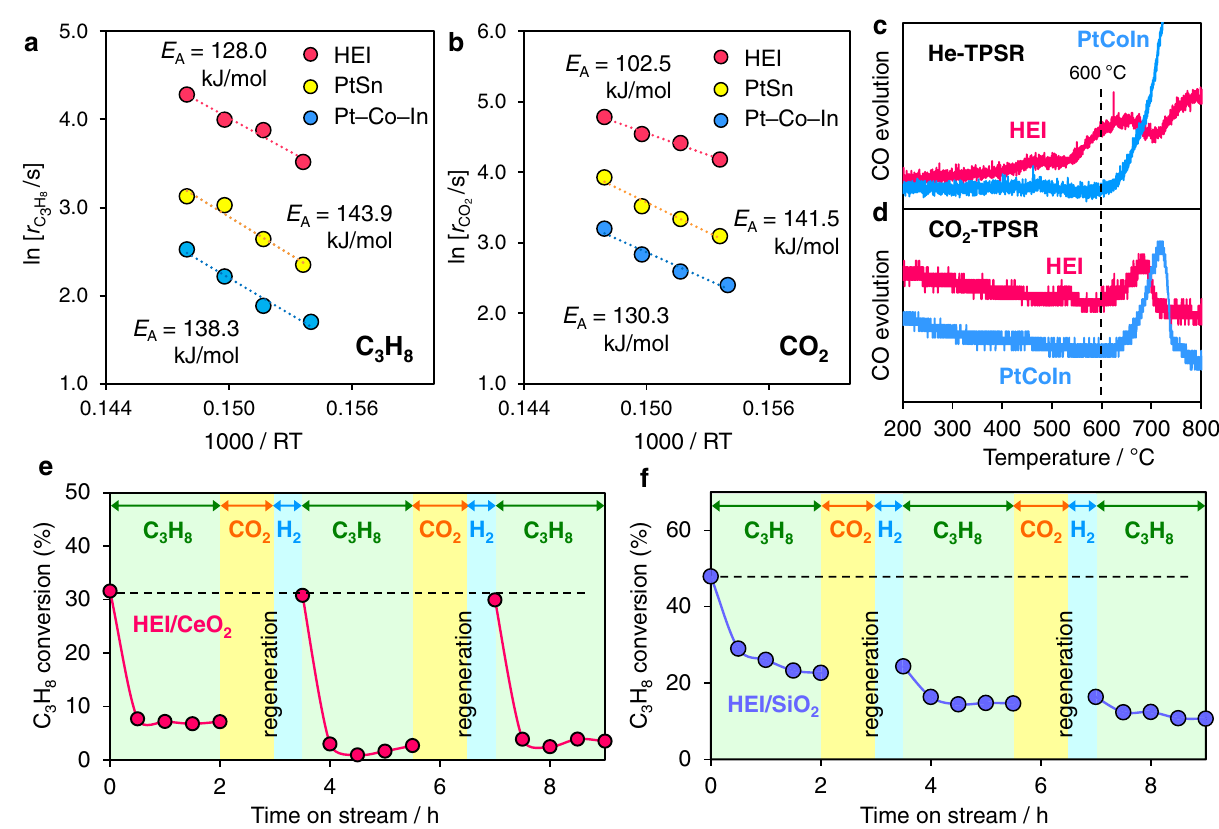
Fig. 4 | Mechanistic study. Arrhenius-type plots for a C 3 H 8 and b CO 2 conversion rates obtained in CO 2 – ODP on HEI/CeO 2 . c He- and d CO 2 -TPSR on the coked Pt – Co – In/CeO 2 and HEI/CeO 2 catalysts (used in CO 2 -ODP for 50h). CO evolution was quanti fi ed by the mass intensity of m/z=28, respectively. Changes in C 3 H 8